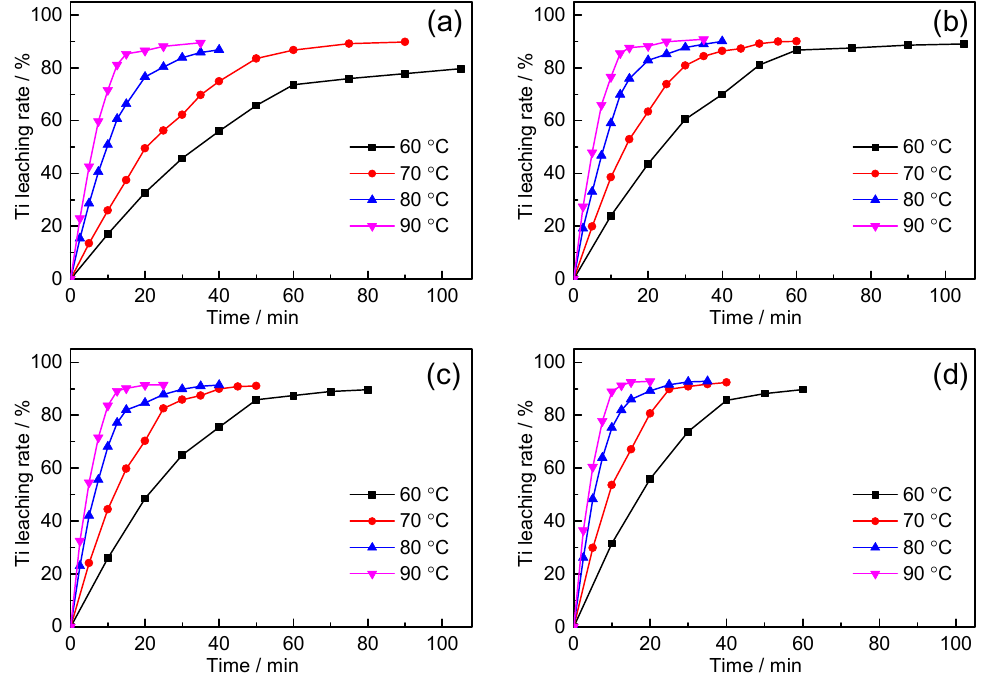
Figure 4. Effects of temperature on the Ti leaching rate with L / S ratio of 20:1 and rotating speed of 200 r/min. ( a ) C F - = 8 mol/L; ( b ) C F - = 10 mol/L; ( c ) C F - = 12 mol/L; ( d ) C F - = 14 mol/L.